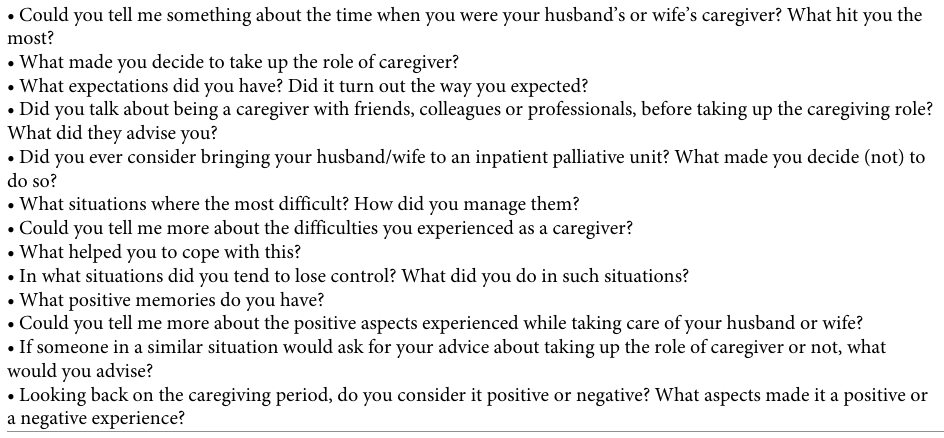
Table 1. Interview guide, adapted to the emerging themes after the third